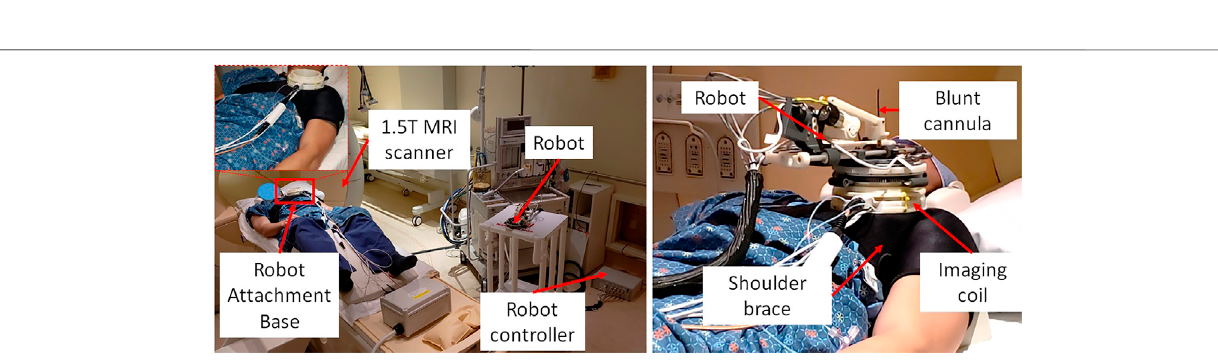
Frontiers in Robotics and AI |